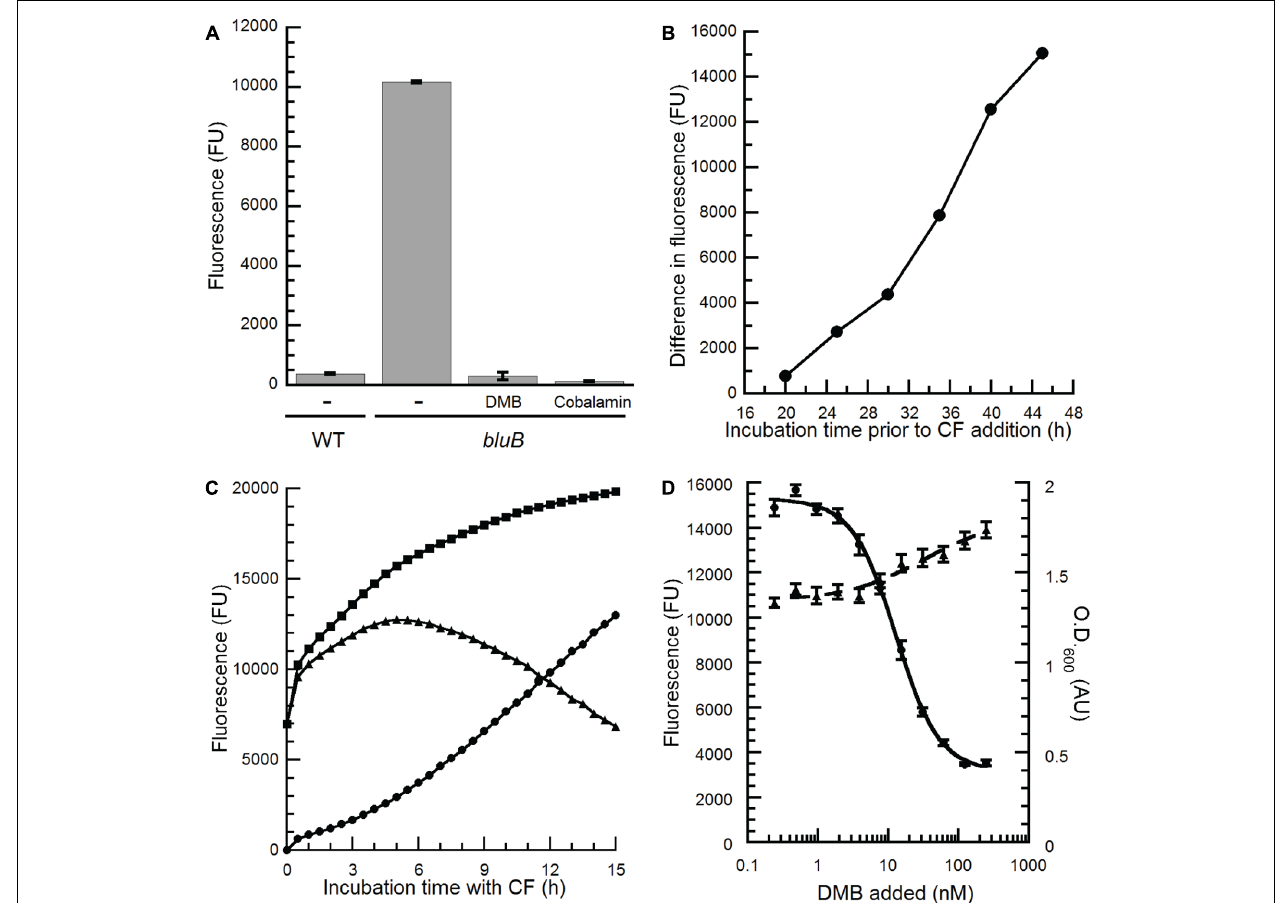
FIGURE 3 | Optimization of the S. meliloti bluB CF bioassay to quantify benzimidazoles. (A) CF fluorescence of liquid cultures ofWT S. meliloti , an S. meliloti bluB mutant ( bluB ), or S. meliloti bluB grown in the absence ( − ) or presence of 0.5 μ M DMB or 1 μ M cobalamin. Error bars represent the SE of three independent experiments. (B) Development of the CFB phenotype as a function of growth. S. meliloti bluB was grown in the presence and absence of 0.5 μ M DMB. At the indicated time points, aliquots were removed and incubated with CF for 5 h.The difference in the CF fluorescence of cultures with and without DMB is plotted. (C) Development of the CFB phenotype as